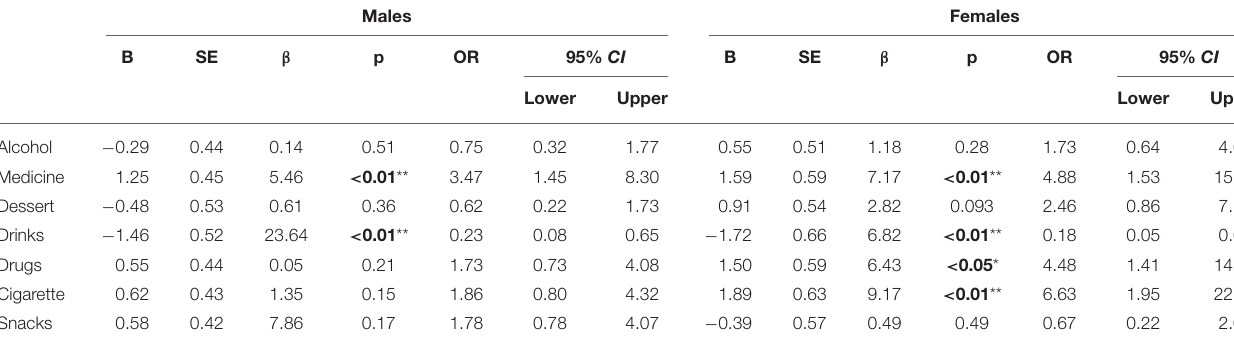
TABLE 3 | Binary logistic regression analysis for anxiety disorder and substance abuse. Males